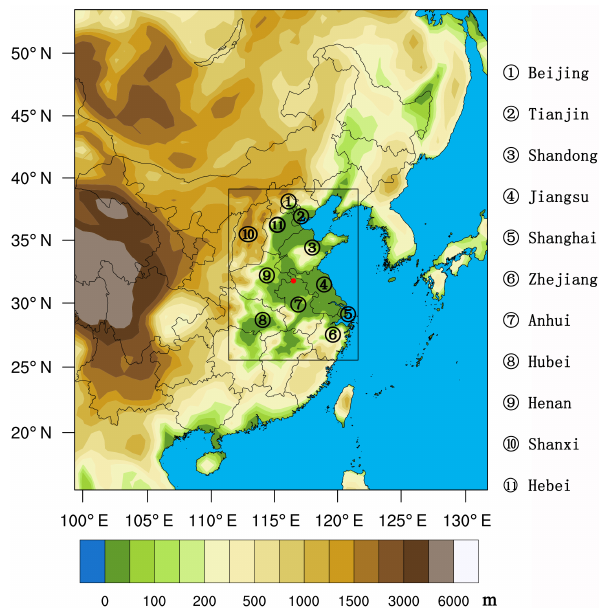
Figure 1. Double-nested Weather Research and Forecasting Model (WRF) modelling domains and topographic field (m); the sampling site (Suixi) is indicated by the red dot. Table 1. WRF-Chem configuration options and